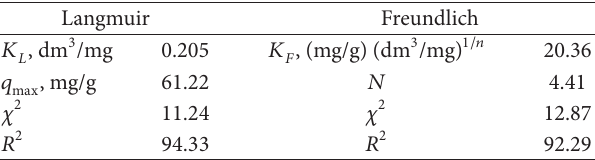
T 3: Equilibrium parameters for adsorption of MB onto PLC. Langmuir